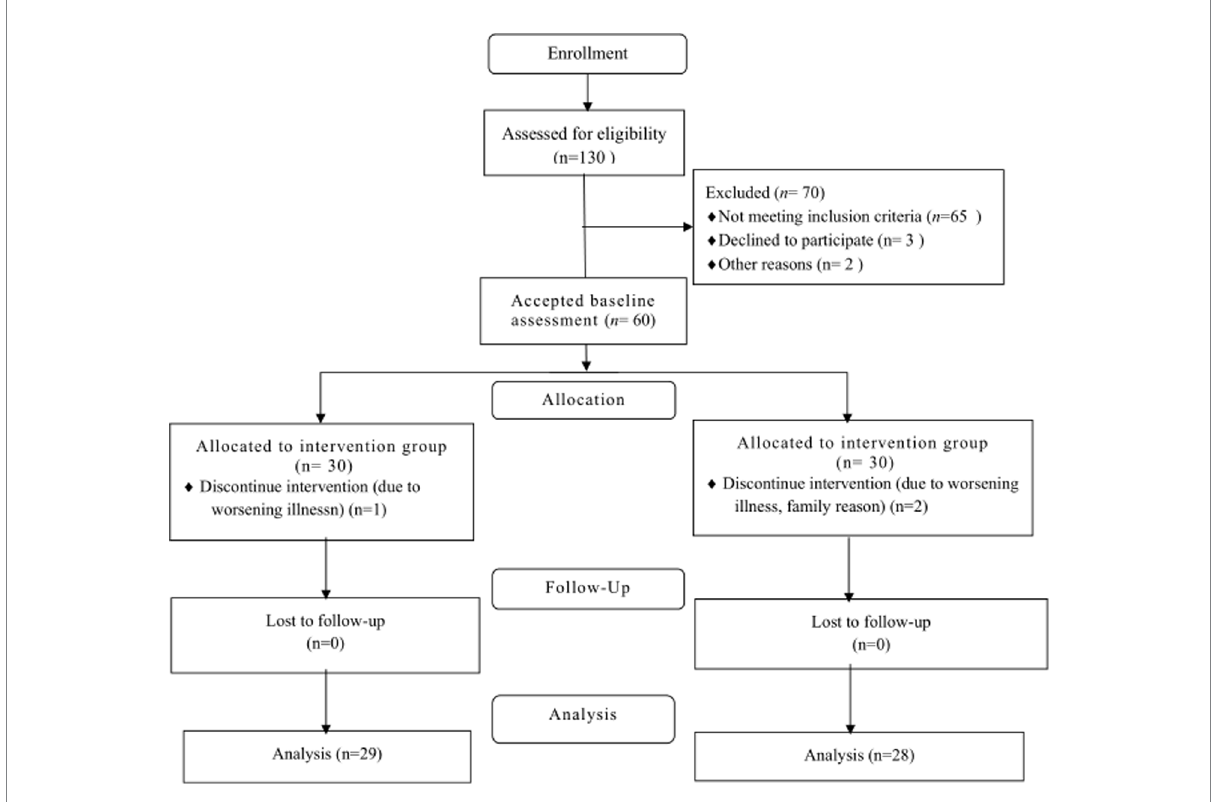
FIGURE 2 Flow chart of study